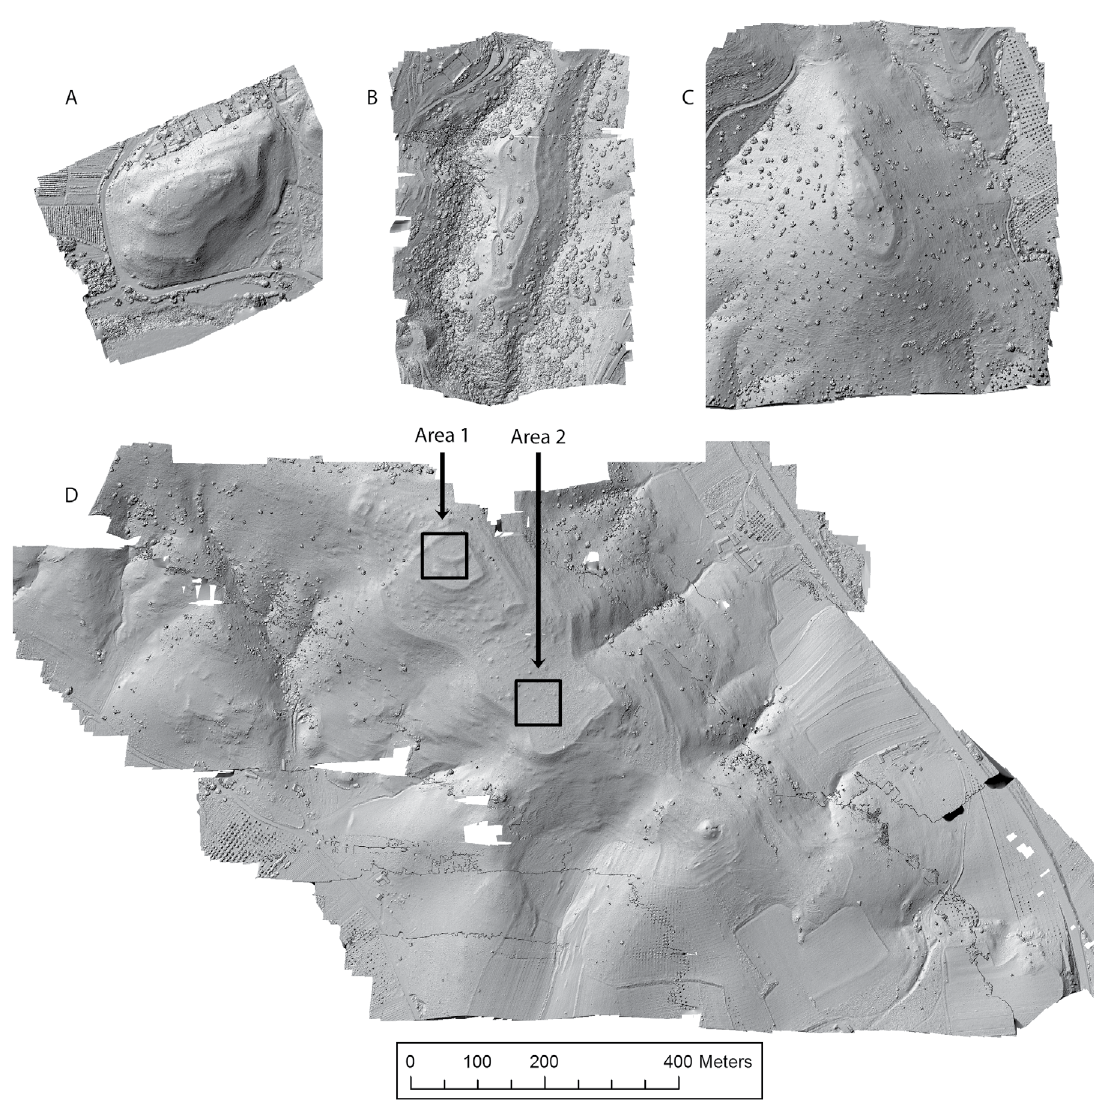
Figure 8: Hillshade models resulting from UAVP survey of sites listed in Table 2: a) Asar Tepe 1; b) Koca Dere; c) Kızbacı Tepesi; d) Kaymakçı. Areas 1 and 2 at Kaymakçı refer to those areas compared in more detail